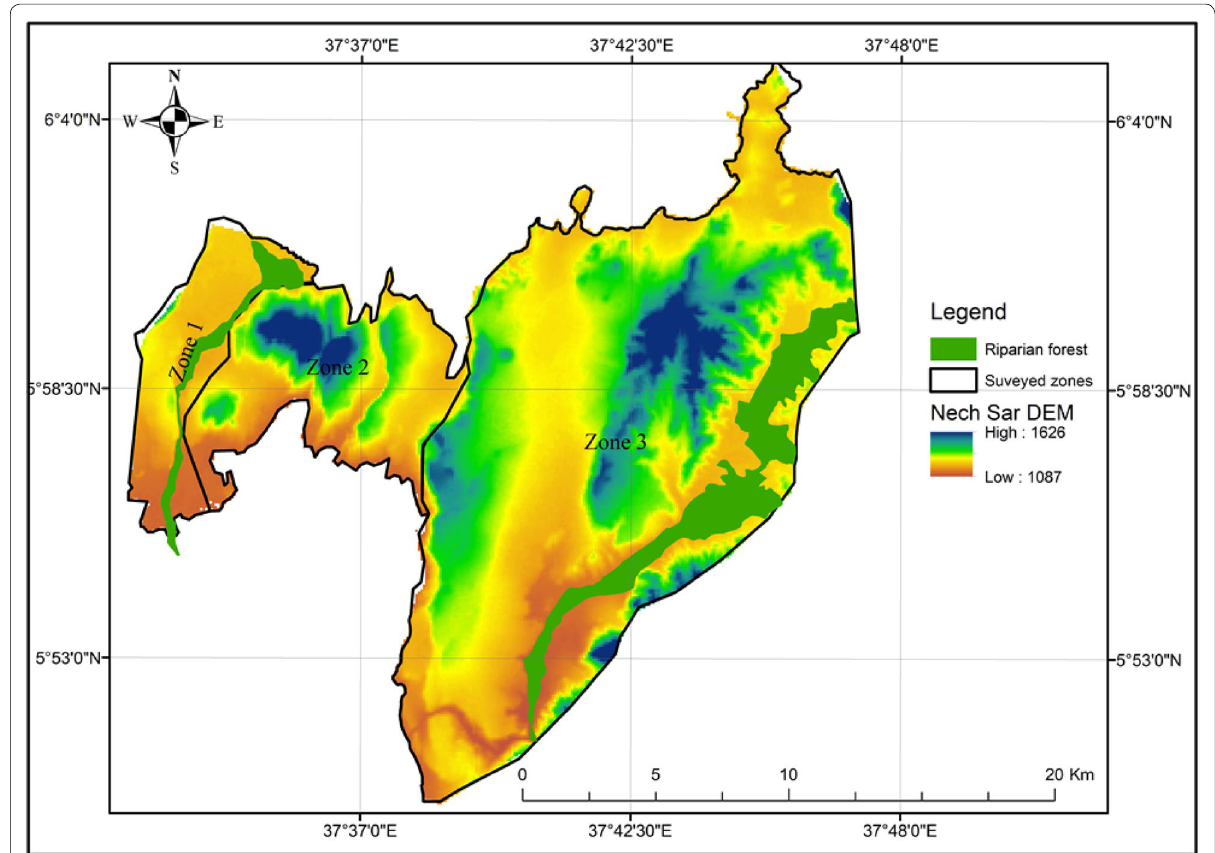
Fig. 2 Stratified zones for wildlife